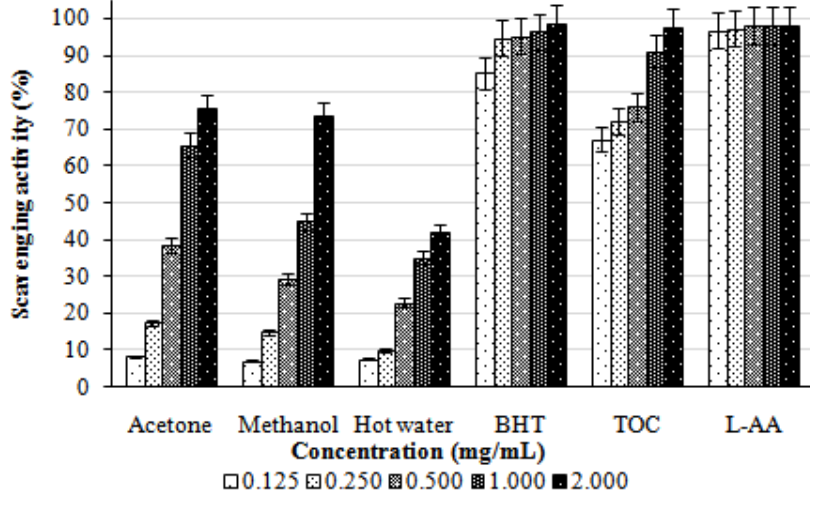
Figure 1. Scavenging activity of various extracts from the fruiting bodies of Lentinus lepideus against 1,1-diphenyl-2-picrylhydrazyl. Values expressed as means ± SD (n = 3); BHT, butylated hydroxytoluene; TOC, α -tocopherol; L-AA, L -ascorbic